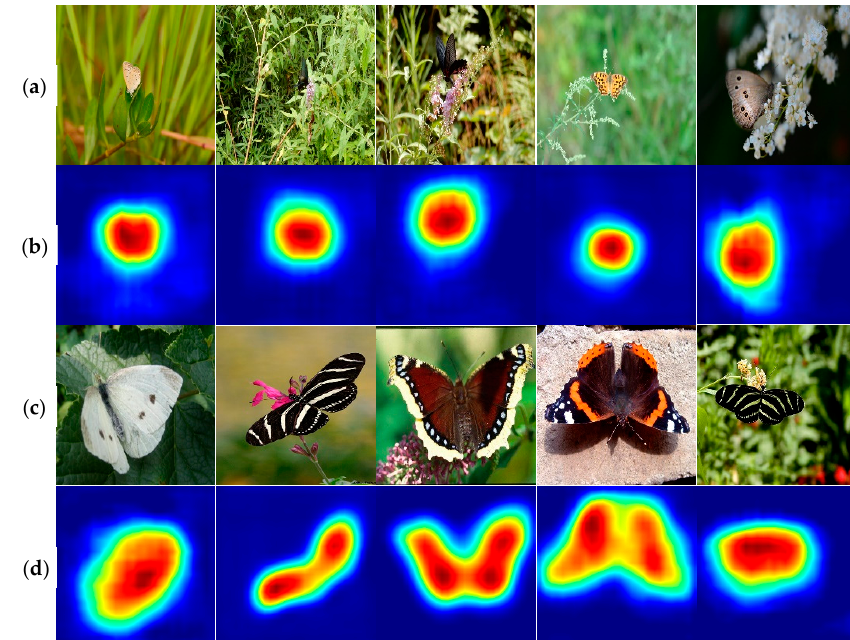
Figure 8. Visualization of the proposed SESADRN’s Gradient-weighted Class Activation Mapping (Grad-CAM). Butterfly sample images of China butterfly dataset ( a ) and their Grad-CAM ( b ); butterfly sample images of Leeds Butterfly Dataset ( c ) and their Grad-CAM ( d ).